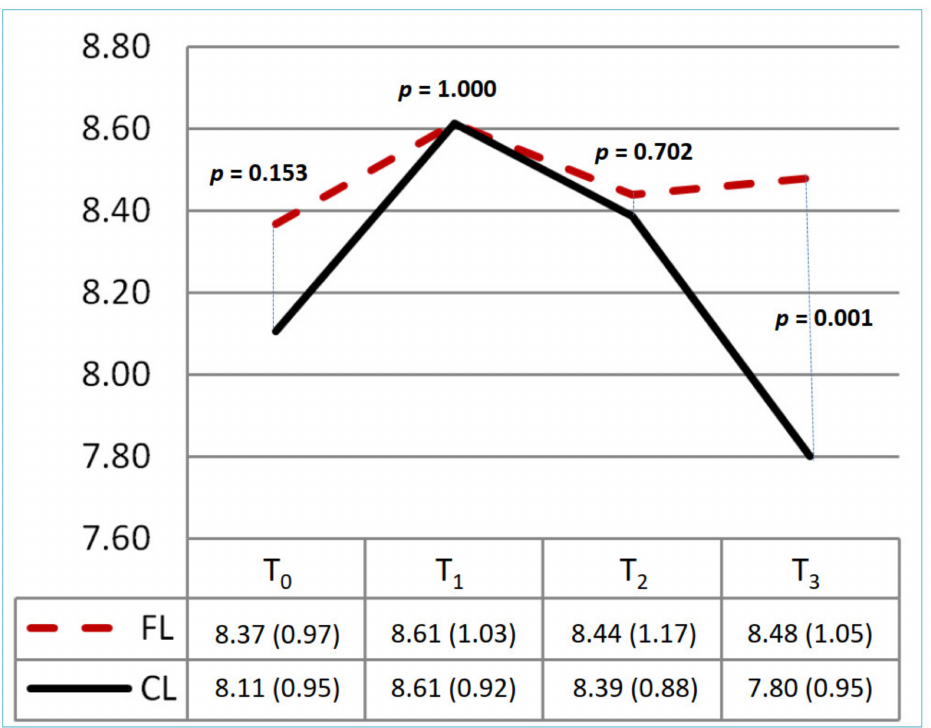
Figure 2. The change in knowledge score between two groups at T 0 –T 3 . CL: conventional learning; FL: flipped learning. Total range: 0–10. T 0 : baseline; T 1 : immediately; T 2 : 1st month; T 3 : 3rd month.